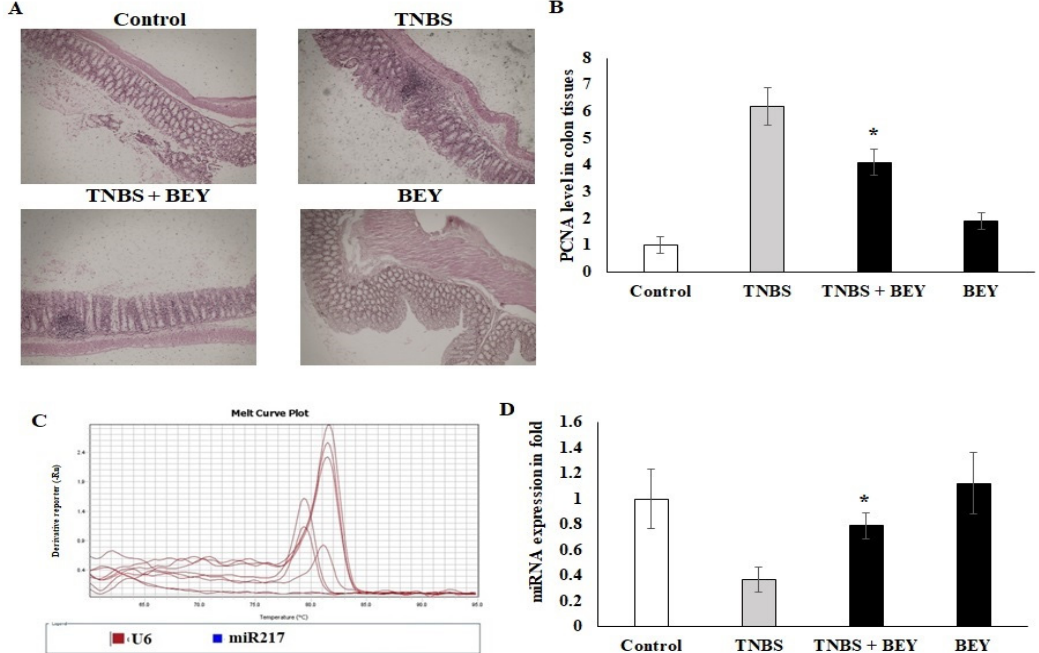
Figure 5. Immunohistochemical expression of PCNA in colon tissues of control and experimental groups of mice. PCNA protein expression is illustrated as brown staining. ( A ) Microscopic imaging of colon tissue with scale bar: 100 μ m. ( B ) The quantitative data expressing the high-grade dysplasia marker PCNA protein level illustrate that there was significant downregulation in the TNBS with Bacillus and Bacillus alone groups compared with the TNBS alone disease group. ( C , D ) The epigenetic marker miR-217 was quantified using real-time PCR. Data are shown as mean ± standard error of the mean ( n = 3). * p < 0.05 represents significance compared to the TNBS vs. TNBS + BEY group. The PCNA expression was further confirmed by microRNA expression of miR217.